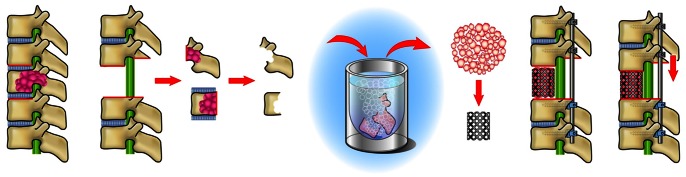
Schema of second-generation TES using tumor-bearing frozen autograft.